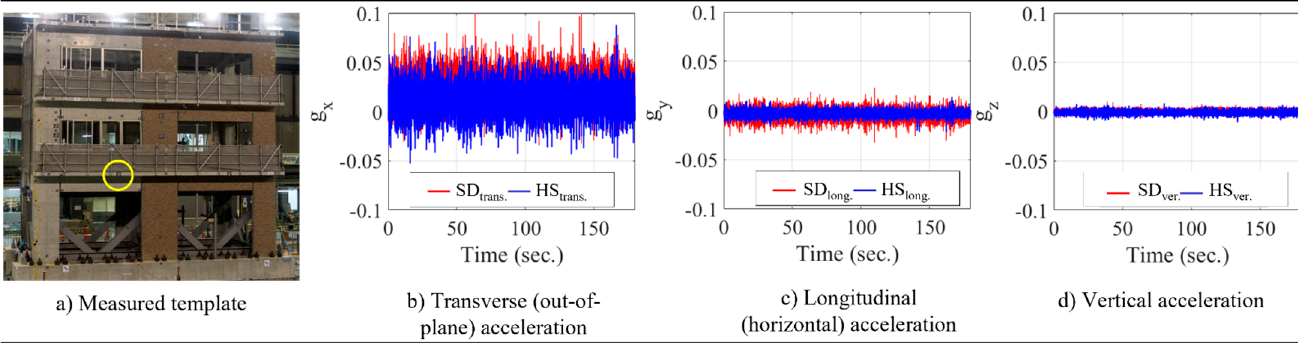
Table 8. Measurement difference between high ‐ speed (HS) system and standalone DSLR (SD) system in assessing high ‐ amplitude seismic excitation. System